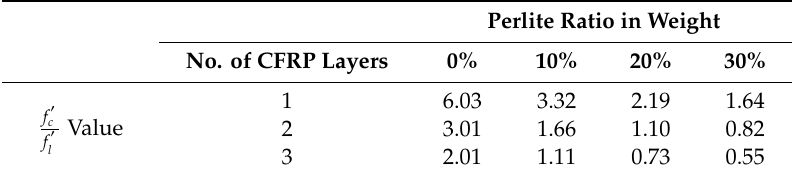
Table 13. The f’ c / f’ l values for a di ff erent amount of perlite ratios and the number of CFRP layers. Perlite Ratio in Weight No. of CFRP